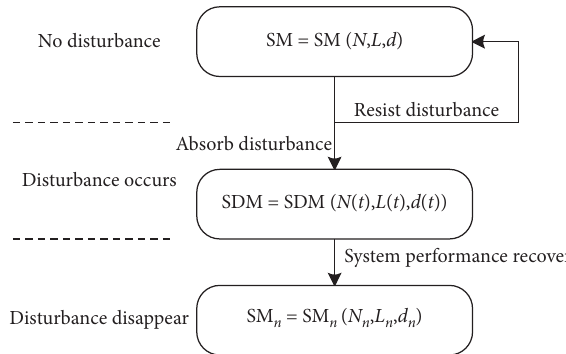
Figure 2: Logical relationship between three